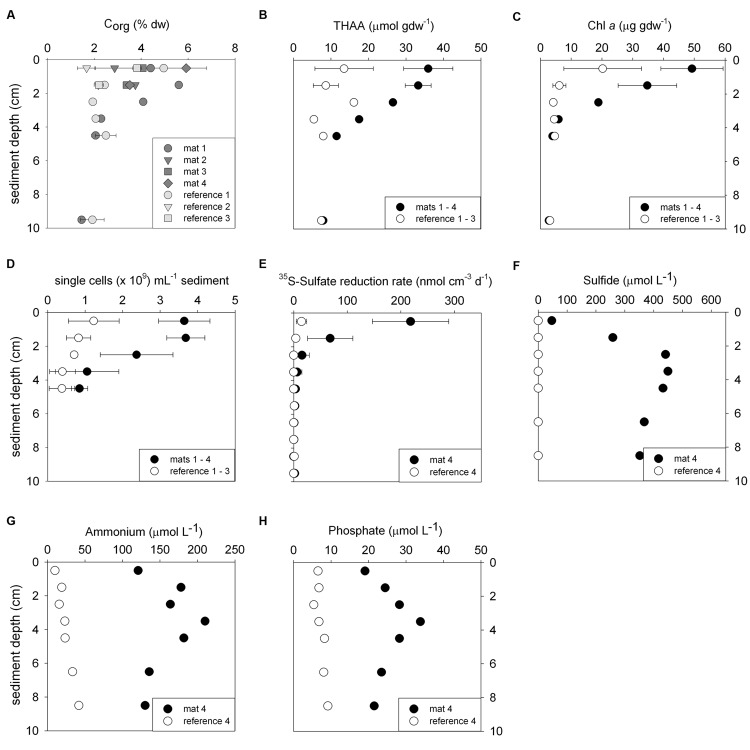
Biogeochemical characteristics of the sediments comparing mat-covered (dark gray/black symbols) and mat-free references sites (light gray/white symbols). Content of organic carbon (A), total hydrolyzable amino acids (THAA) (B) and chlorophyll a
(C), total single cells (D), radiotracer-based sulfate reduction rates (E), concentration of sulfide (F), ammonium (G) and phosphate (H). Symbols represent averages and error bars standard deviations when replicates were available (±, n = 3–5).